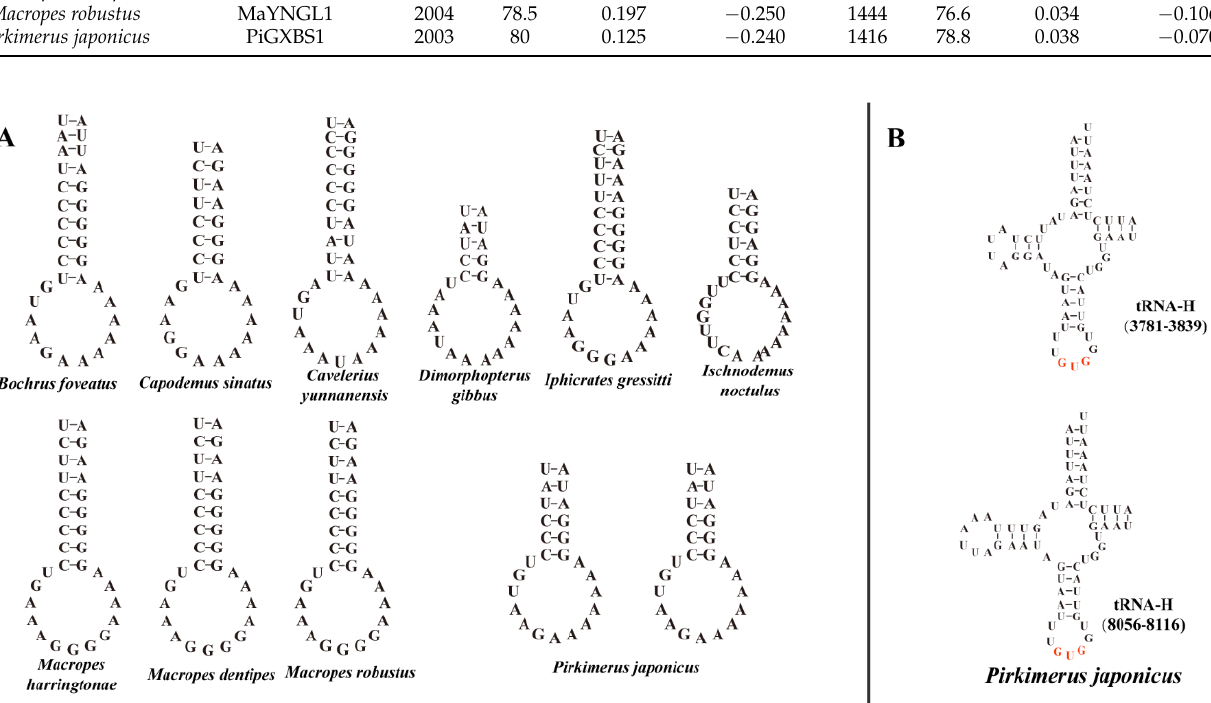
Figure 2. Structure of the mitogenomes of Pirkimeru japonicus . Arrows indicate the orientation of gene transcription. Ticks in the inner circle indicate sequence length.